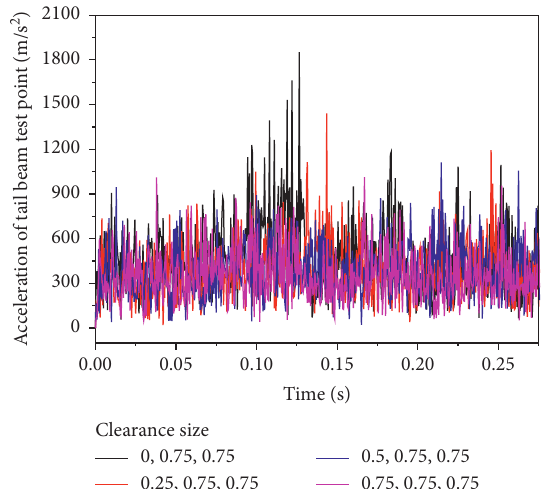
Figure 8: Spring stress.